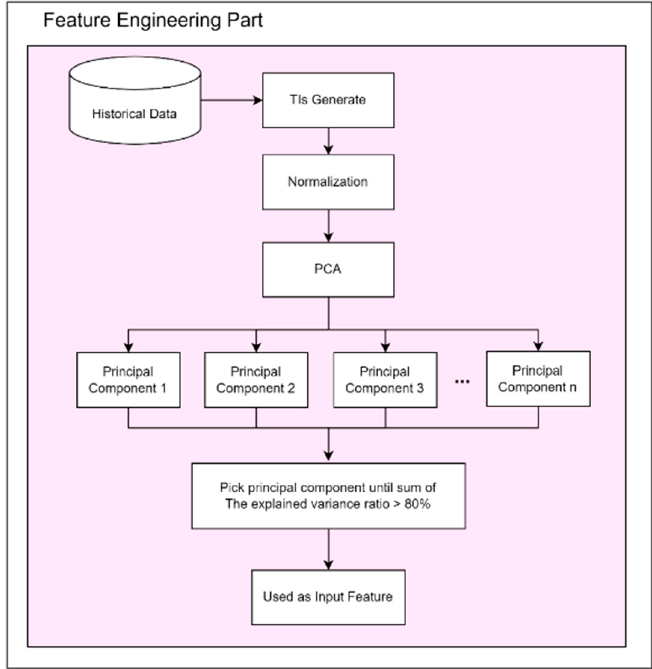
Figure 5. Technical Indicator Component Creation.